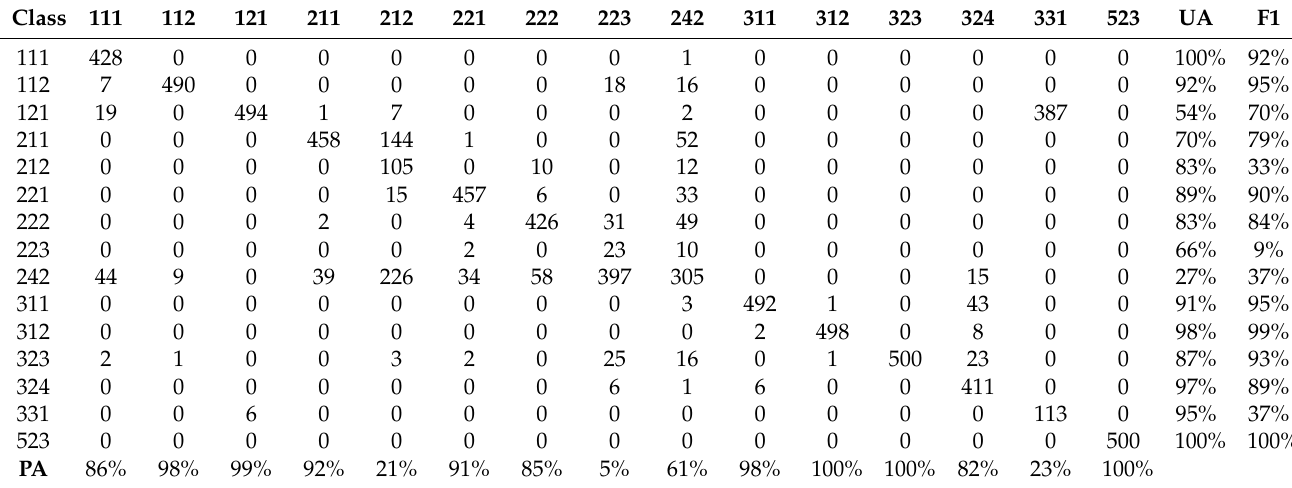
Table 7. Confusion matrix of the Catalonia area (SVM RBF, Sentinel-2 images, OA: 76%, Kappa coefficient 0.74, UA—User Accuracy, PA—Producer Accuracy,